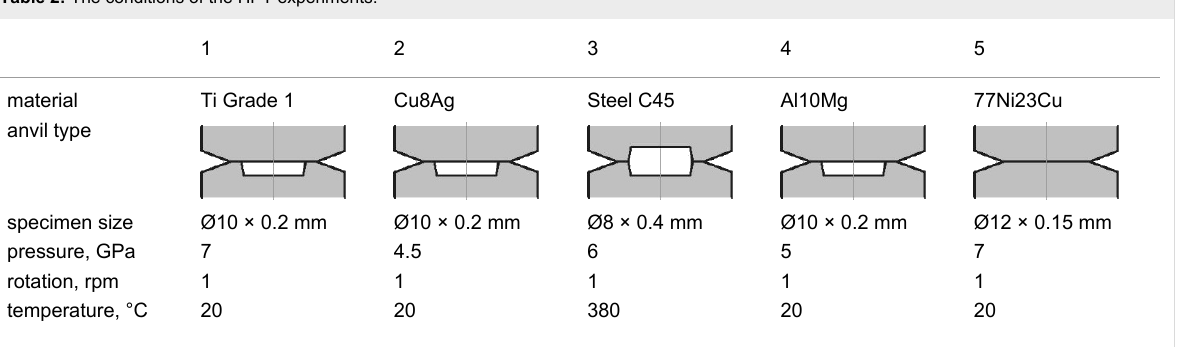
Table 2: The conditions of the HPT experiments.